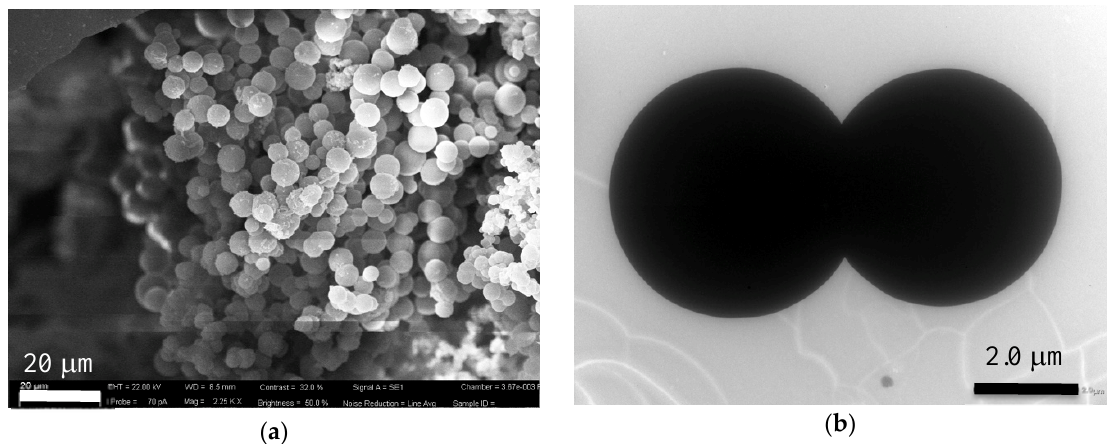
Figure 1. Typical ( a ) scanning electron microscopy (SEM) and ( b ) transmission electron microscopy (TEM) images of the hydrochar obtained after 6 h of the HTC of orange juice at 800 °C.